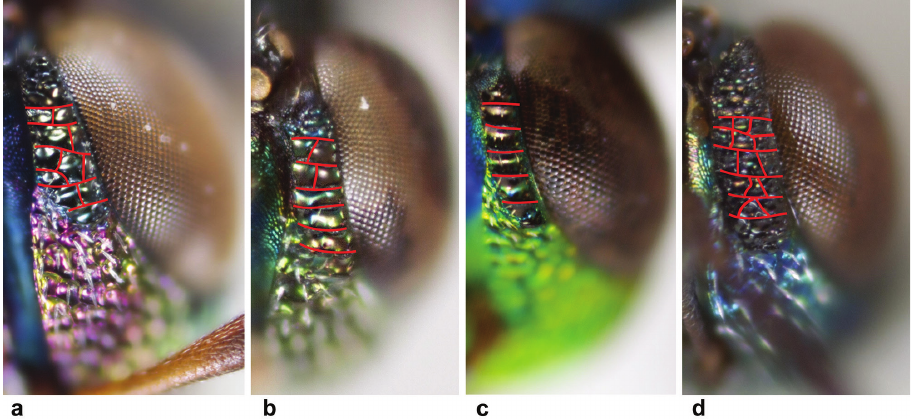
Figure 1. Four different types of corona structure in Oodera , in dorso-frontal view. Antennal scrobes are left of corona, eye is right of corona; a interrupted (exemplar species imaged: O. namibiensis sp. n.) b continuous (exemplar species imaged: O. formosa ) c square (exemplar species imaged: O. longicollis ) d three- to four-part (exemplar species imaged: O. leibnizi sp. n.). For additional definitions of corona types see main